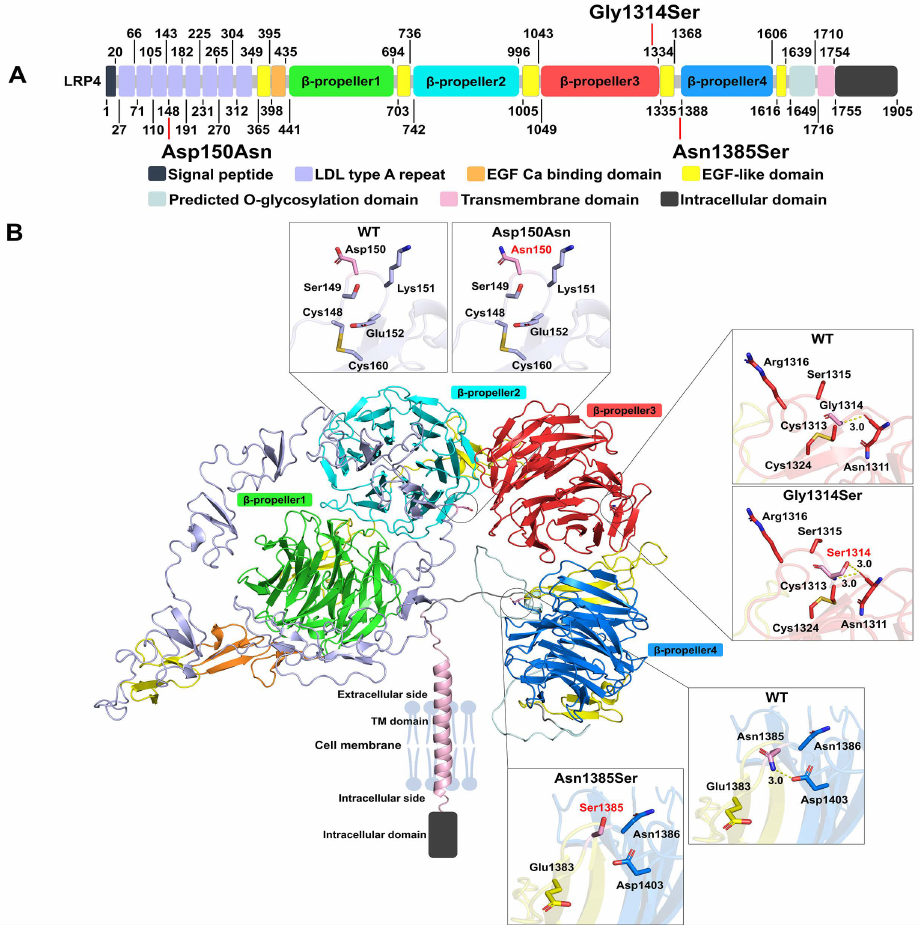
Figure 5. Structural context of LRP4 mutations. ( A ) Map of structural domains and mutations within the LRP4 protein sequence. Structural domains are coded by color as indicated. The residue numbering is based on accession number NCBI: NP_002325.2. The starting position of each structural domain is marked on the bottom and the ending position on the top. ( B ) Three-dimensional model of the LRP4 structure predicted by AlphaFold2 with structural domains in the same colors as in part A. Magnified views of the wild type and mutated amino acids and surrounding amino acids in stick representation are shown to the side to indicate the molecular environment. Possible polar interactions are shown as dashed lines. Oxygen atoms are shown in red, nitrogen in blue and sulfur atoms in yellow, while carbon atoms are colored according to the domain color. The intracellular domain has no predicted structure and is shown schematically as a